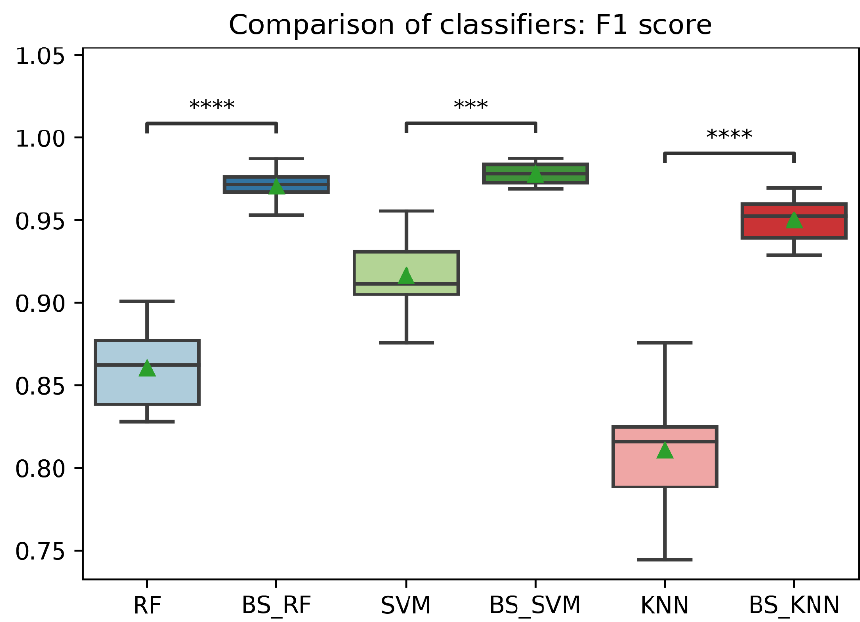
Figure 11. Comparison of F1-score between classification models with imbalanced and oversampled data. RF = Random Forest; BS_RF = Borderline-SMOTE Random Forest; SVM = Support Vector Machine; BS_SVM = Borderline-SMOTE Support Vector Machine; KNN = K-nearest Neighbors; BS_KNN = Borderline-SMOTE K-nearest Neighbors; ***: p ≤ 0.001; ****: p ≤ 0.0001.